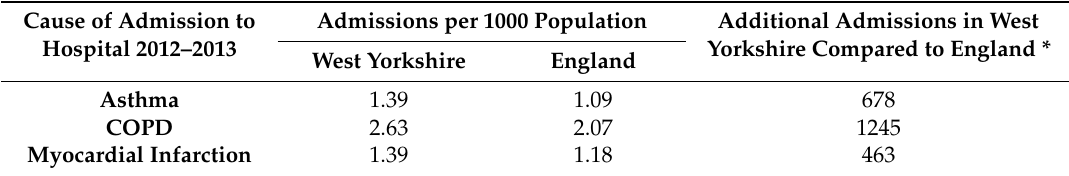
Table 1. West Yorkshire Hospital Admissions for Asthma, COPD and Myocardial Infarction, 2012–2013 (Source: WYLES